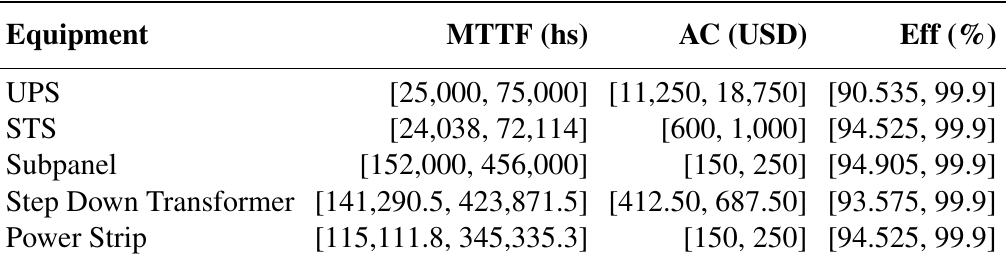
Table 2. Benchmark range values for the